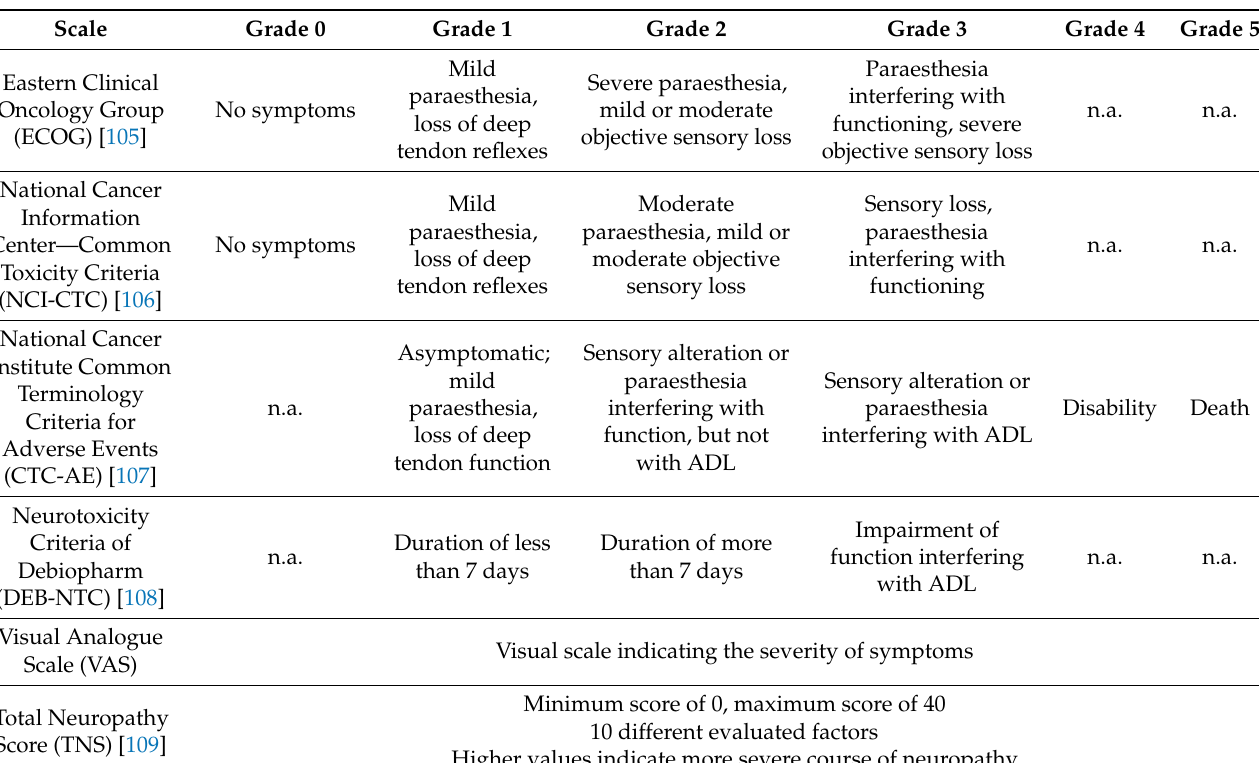
Table 4. Comparison of different neuropathy assessing